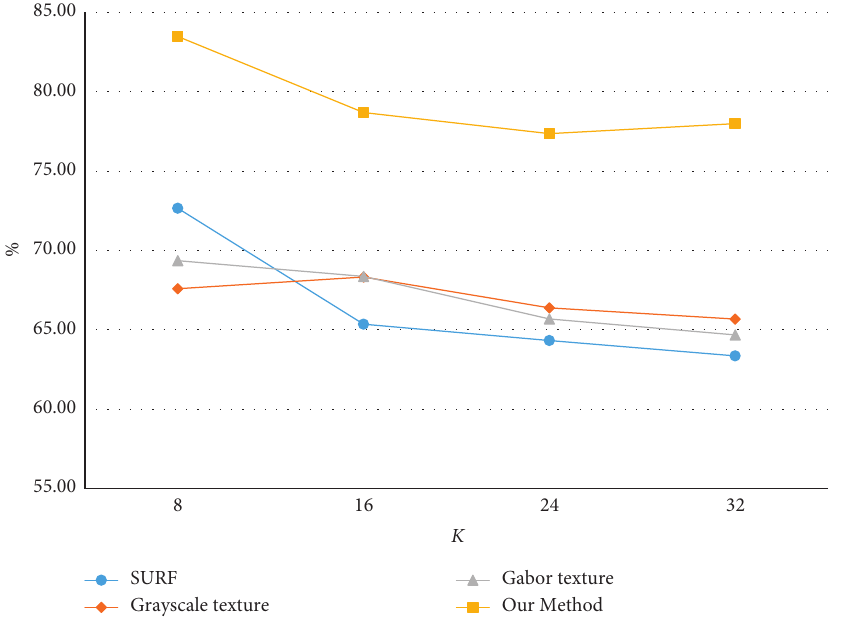
Figure 10: Comparison of features of brain medical images.